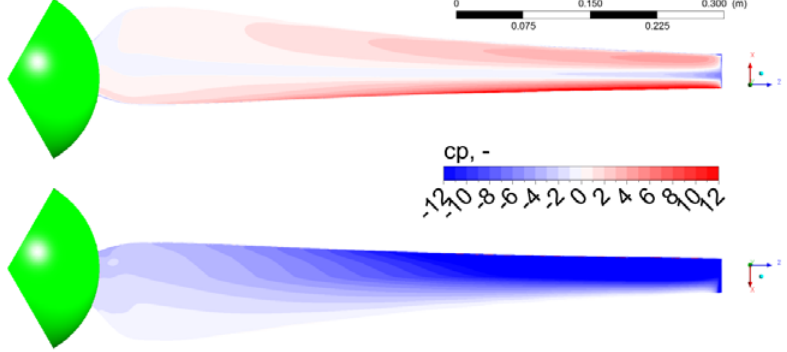
Figure 5. Pressure coefficient distribution at blade pressure (top) and suction (bottom) side ( V = 12 m/s, TSR = 5).